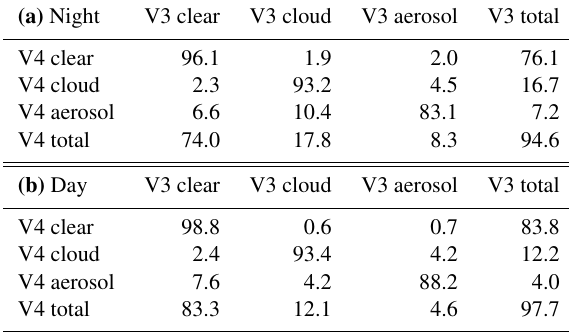
Table A1. Confusion matrices for V3 and V4 detection and clas- sification derived from 1 year (2008) of the V3 and V4 cloud and aerosol profile products. The first three rows represent the V3 clear air, cloud, and aerosol categories, respectively. Similarly, the first three columns indicate the V4 clear air, cloud, and aerosol cate- gories. The numbers in the diagonal elements are the percentages of each category for which the classification remained unchanged from V3 to V4. The numbers in the non-diagonal elements are the percentage changes from one category to another relative to each V3 category. The last column is the fraction of each V3 category and the last row is the fraction of each V4 category relative to the total number of